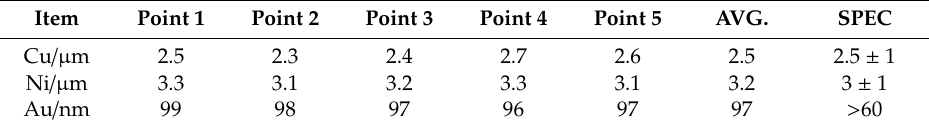
Table 9. The thicknesses of Cu, Ni, and Au in RDL formation process.